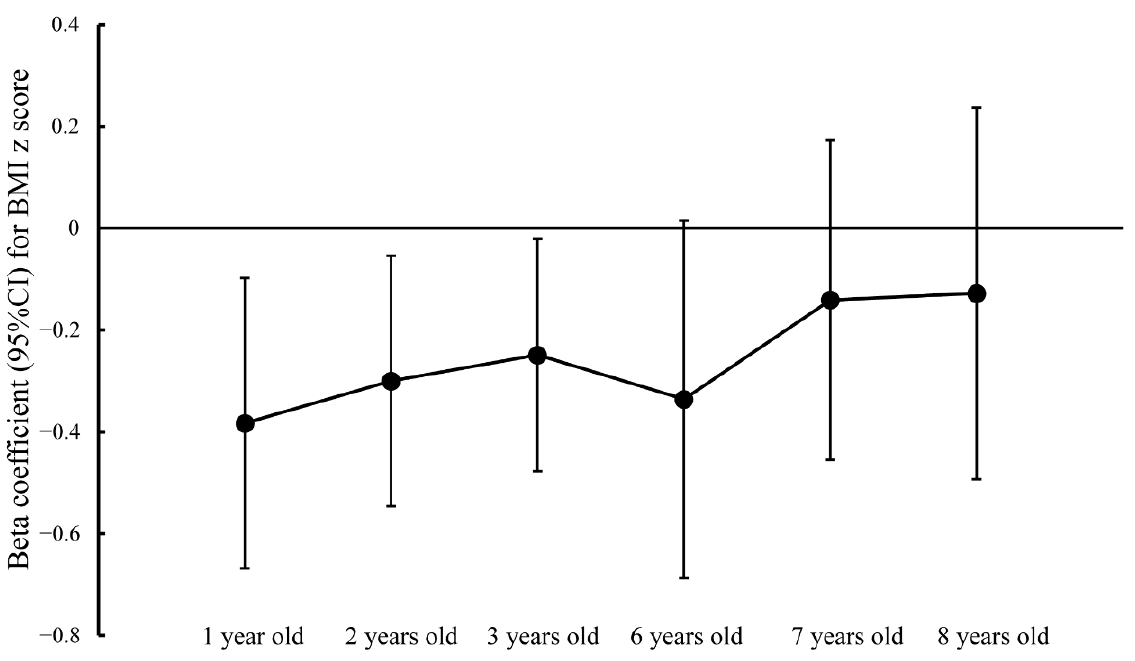
Figure 2. Generalized linear models for associations between prenatal Mn exposure and body mass index z score at different ages. (Abbreviation: BMI—body mass index).